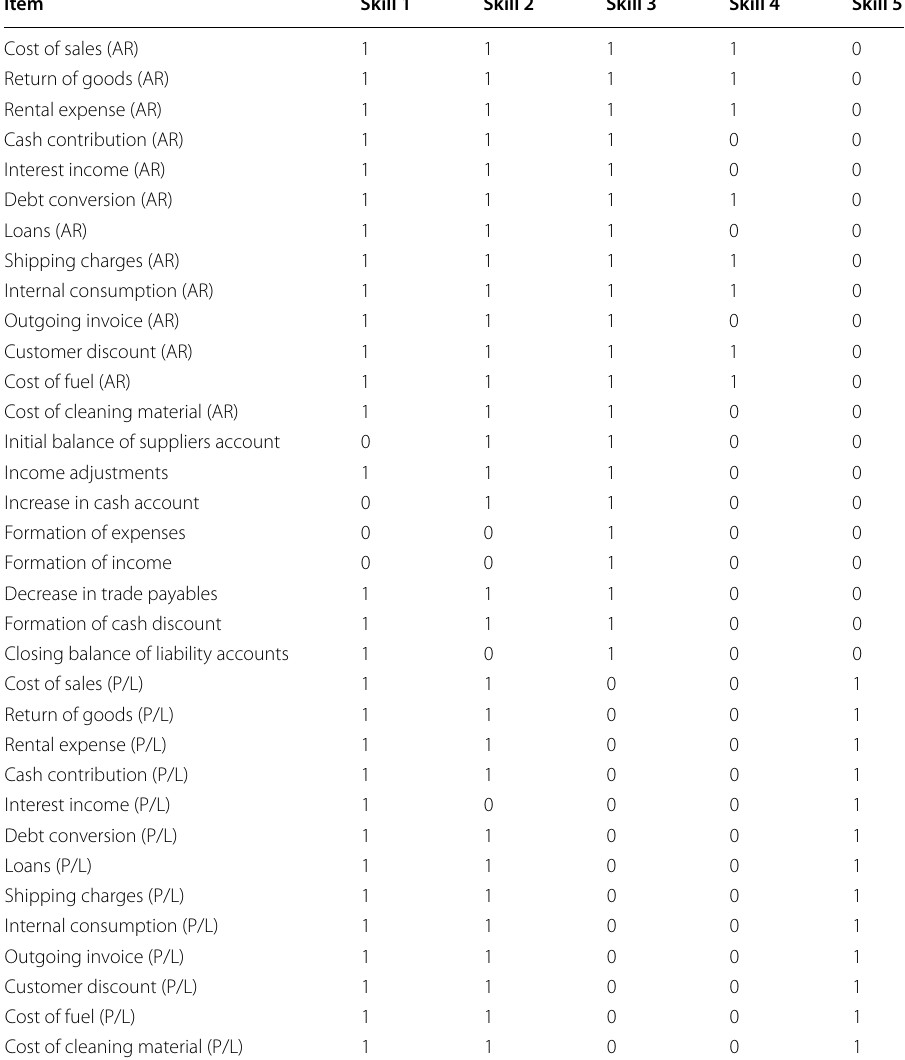
Table 1 Q-Matrix used for cognitive diagnosis in introductory